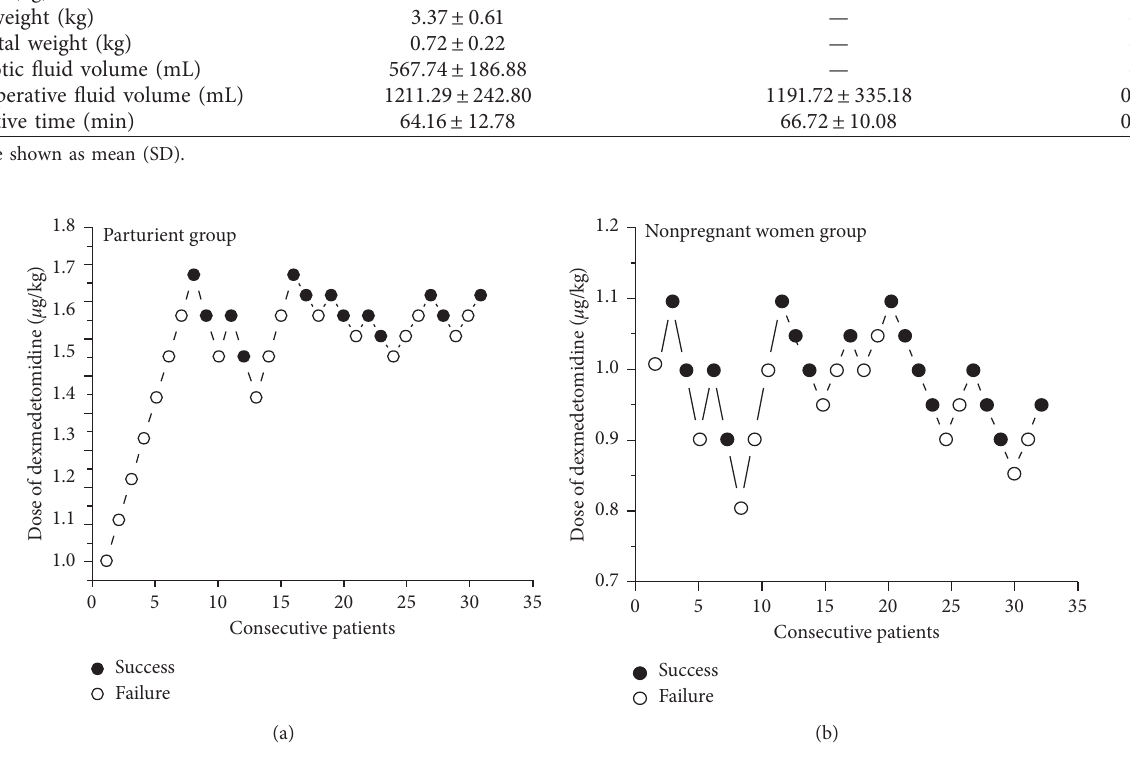
Figure 1: Responses of consecutive patients receiving dexmedetomidine sedation in postpartum parturient group and nonpregnant women group according to the modified up-and-down sequence.